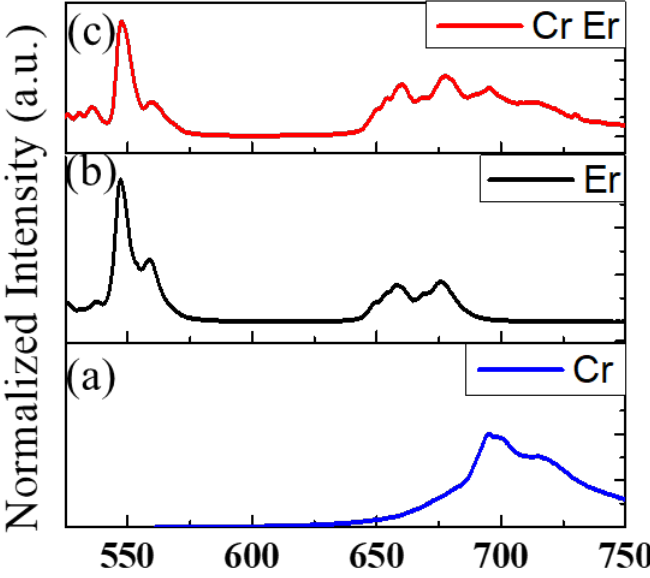
Figure 4. PL spectra of ( a ) ZGSO-3:Cr, ( b ) ZGSO-3:Er, ( c ) ZGSO-3:Cr, Er. All PL measurements are obtained from the samples under 365 nm UV excitation.